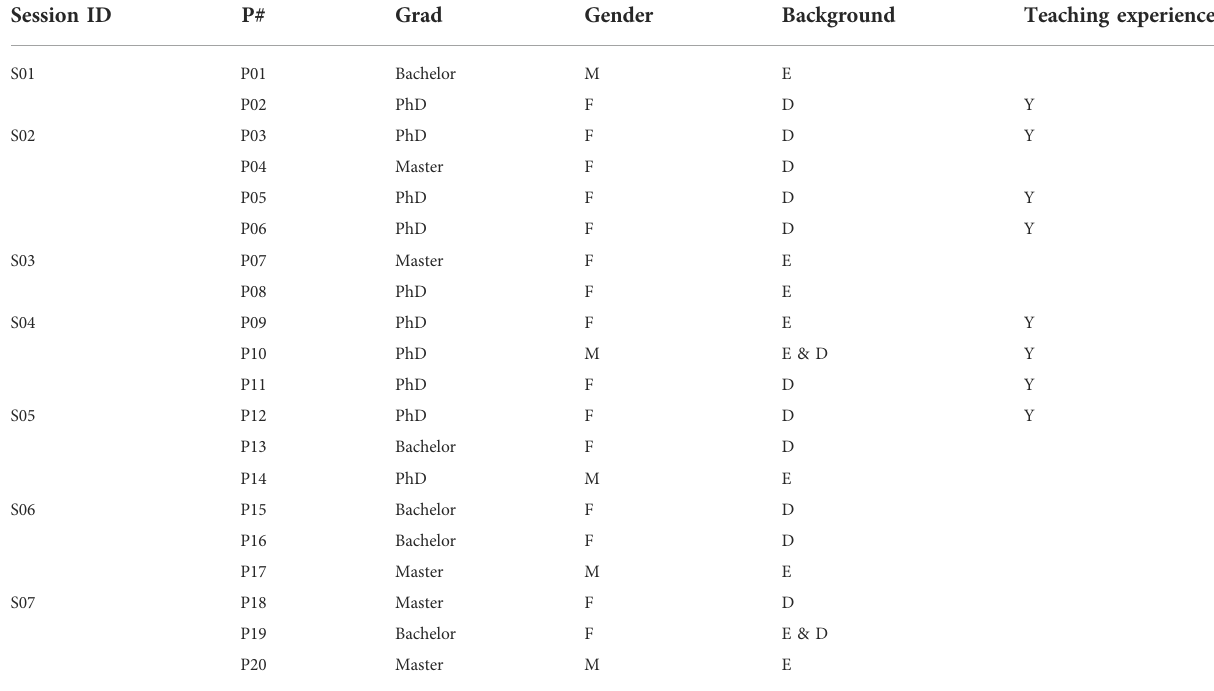
TABLE1Sessionsandparticipants ’ information(P#:ParticipantID,F:Female,M:Male,D:Design,E:Engineering),Alltheteachingexperiencereported was university level. Session